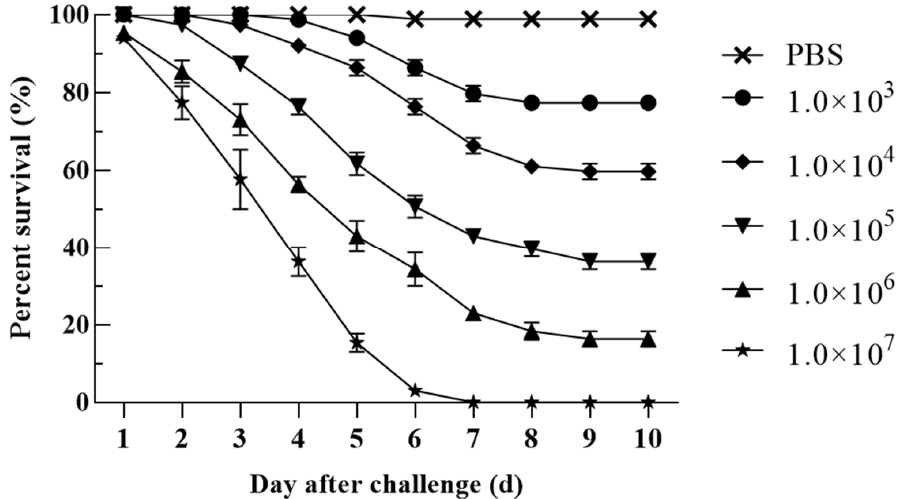
Figure 7. Pathogenicity of different concentrations of H-701 bacterial solution to hybrid sturgeon (Injection concentration: CFU/g fish weight).